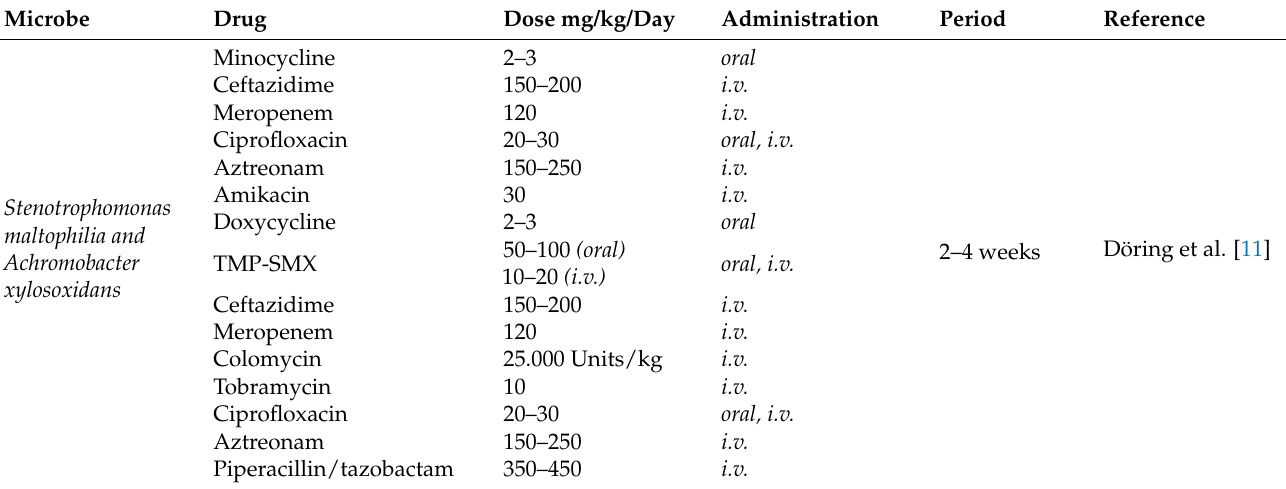
Table 5. Recommended antibiotics for Stenotrophomonas maltophilia and Achromobacter xylosoxidans infection in CF